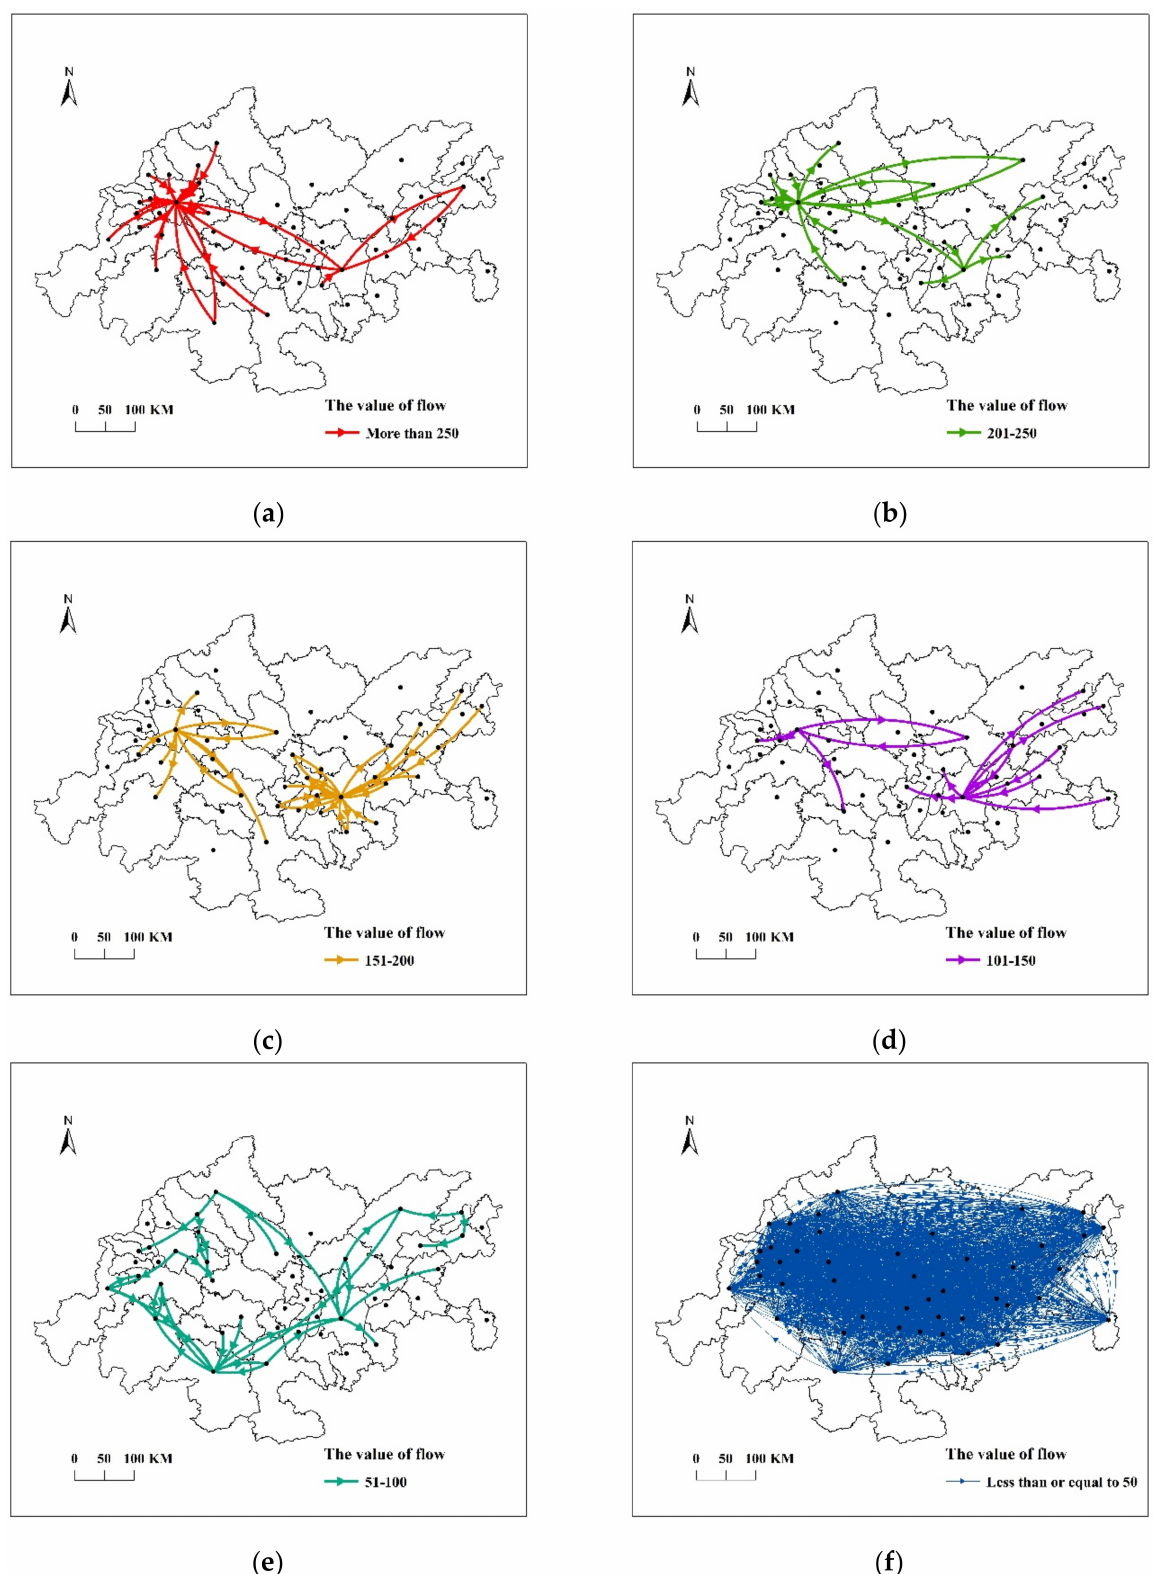
Figure 3. Six levels of directional information flow in study area. ( a ) Level 1, ( b ) Level 2, ( c ) Level 3, ( d ) Level 4, ( e ) Level 5, ( f ) Level